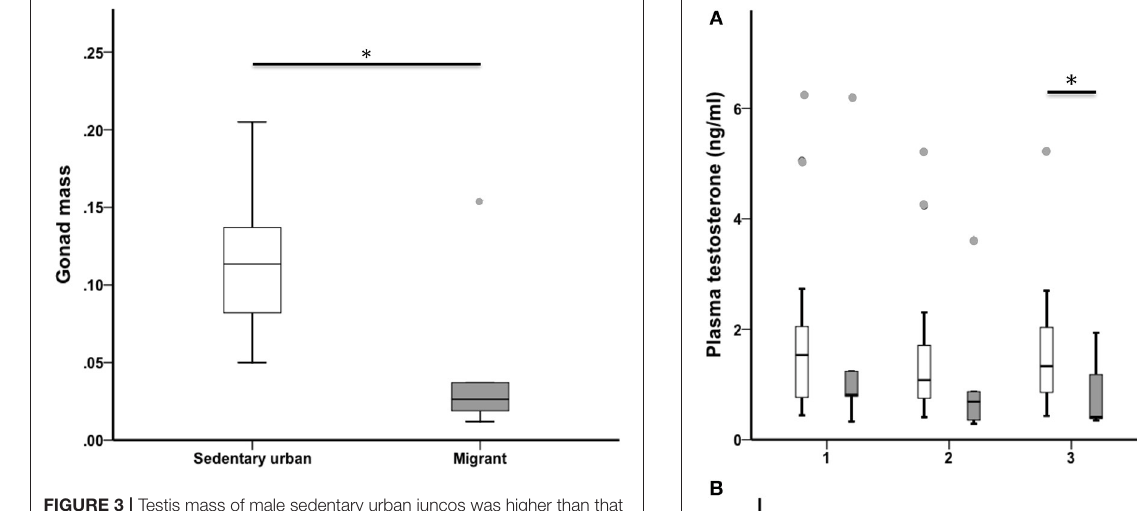
19, n migrant = 6, p = 0.013) (Figure 3) . Median gonad mass was 0.113 g for sedentary urban juncos and 0.024 g for migrants.